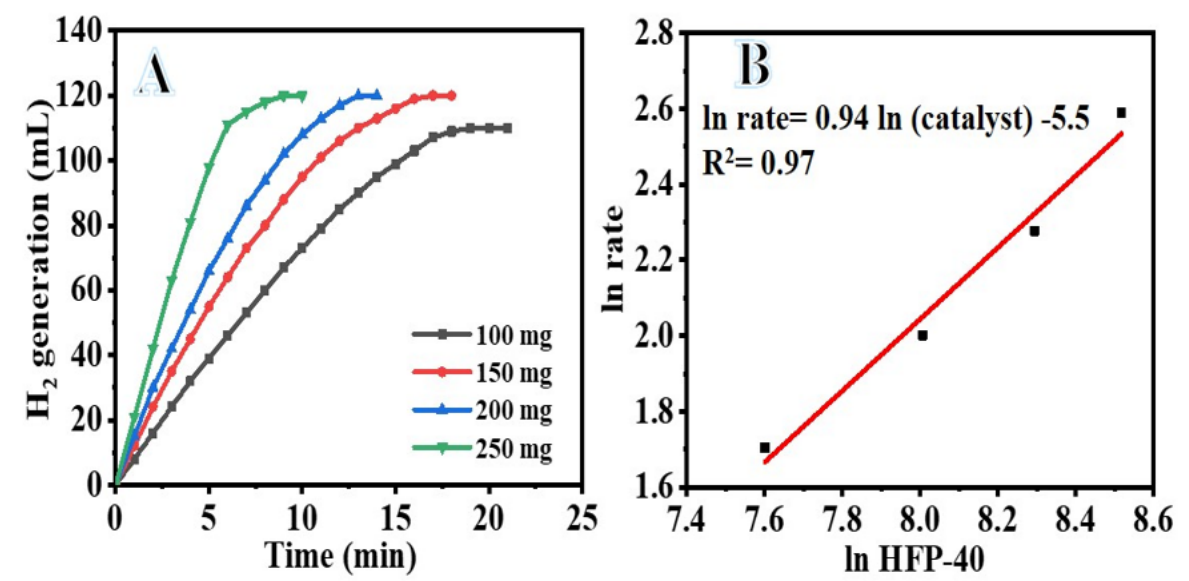
Figure 9. The influence of PVHF-40 membrane amount on dehydrogenation of SBH ( A ) and the ln H 2 generation rate vs. ln PVHF-40 amount ( B ). [SBH] = 1 mmol and T = 298 K.